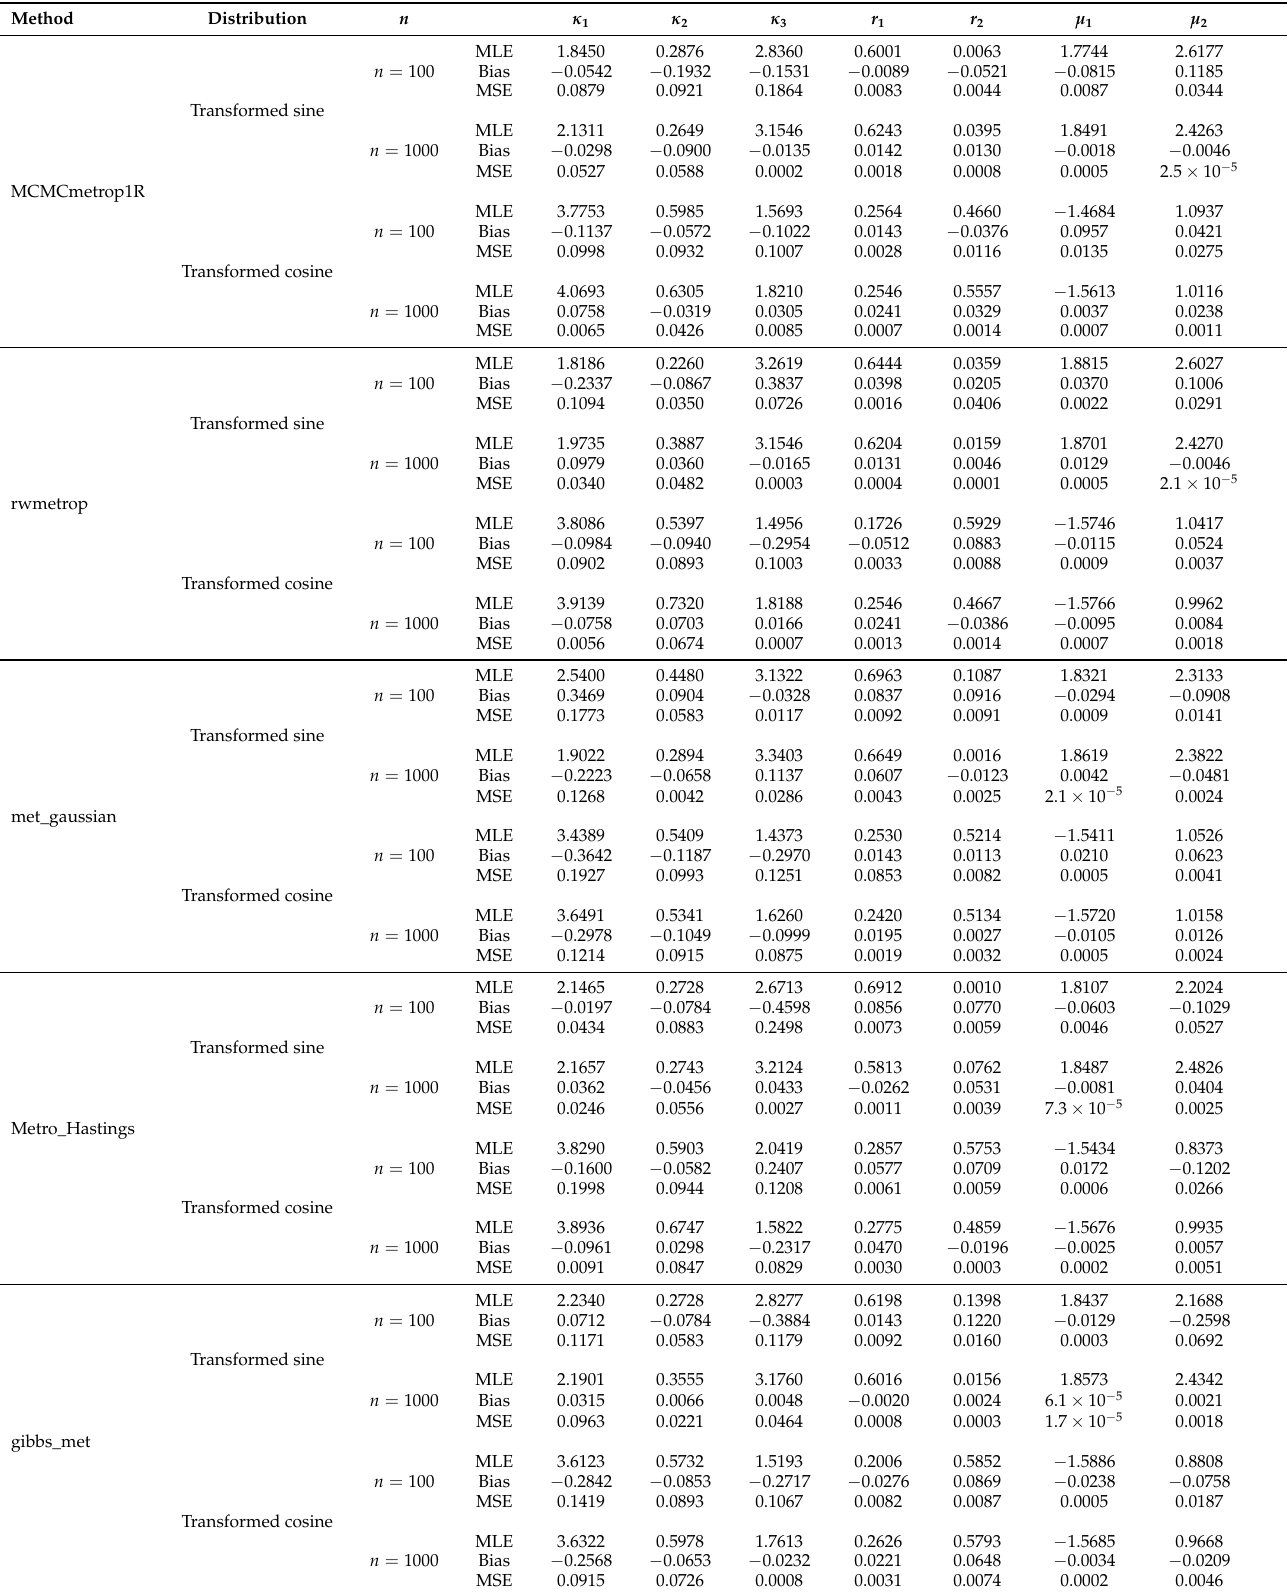
Table 4. Maximum likelihood estimates of parameters and bias, and the MSE of the estimates for the simulated data obtained from each